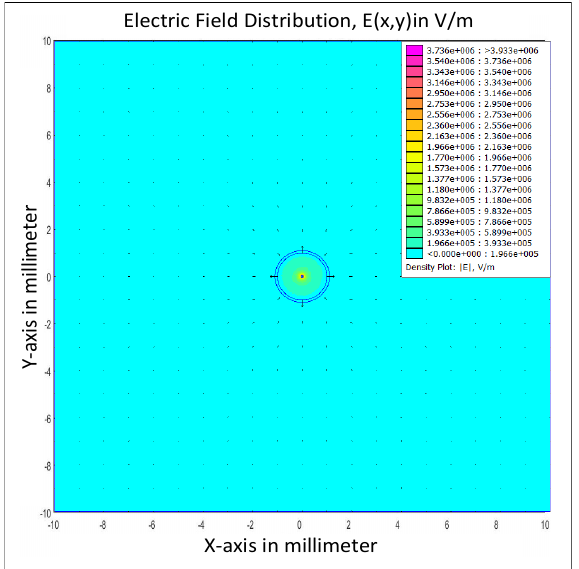
Figure 11. The electric field distribution of the proposed device when the voltage is